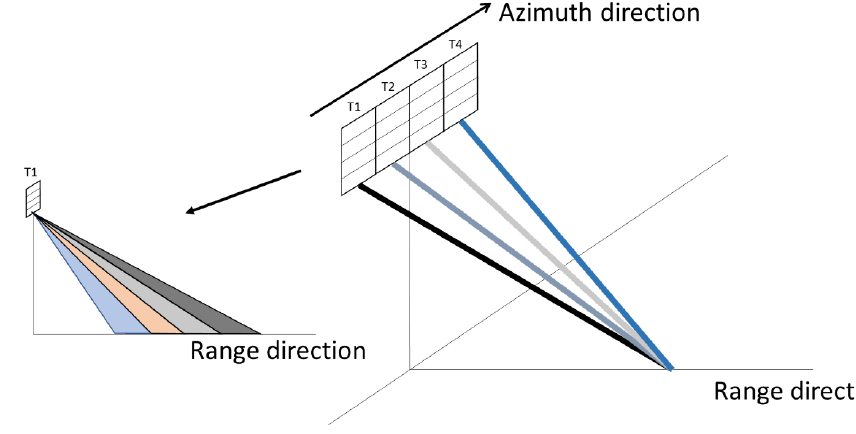
Figure 5. Schematic diagram of the proposed system.